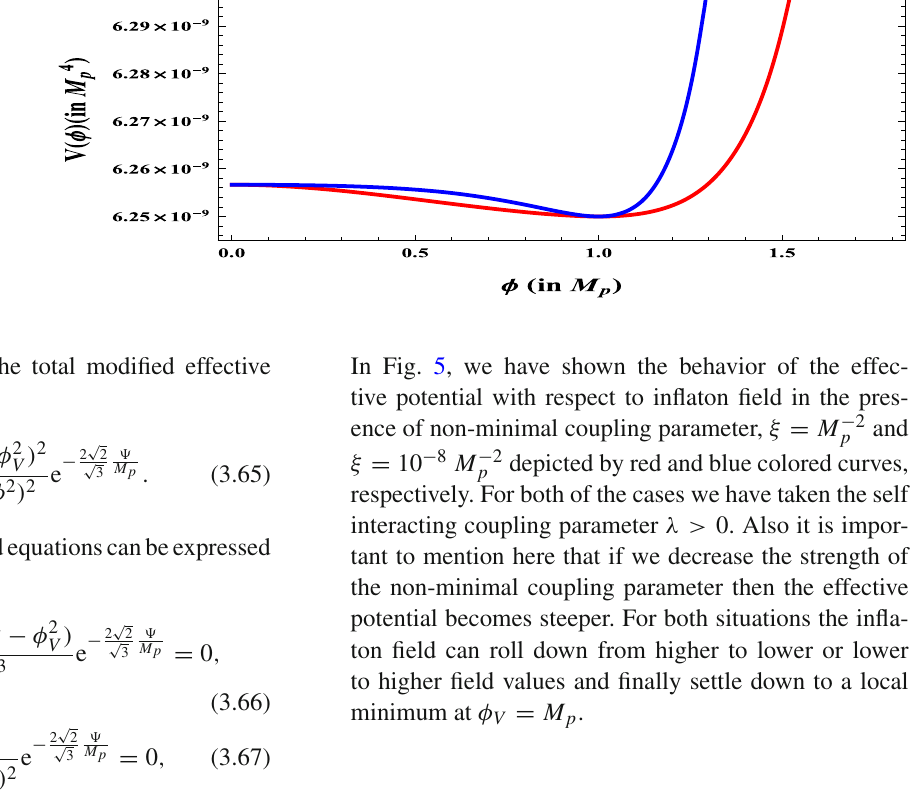
Fig. 5 Behavior of the modified effective potential in presence of non-minimal coupling in R 2 gravity